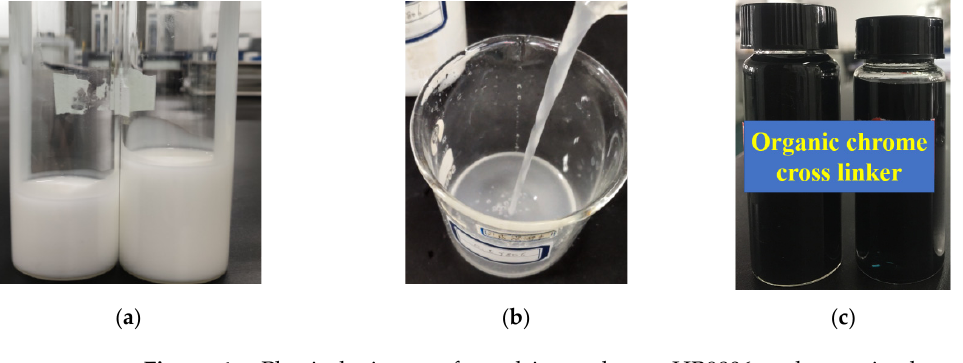
Figure 1. Physical picture of emulsion polymer HR9806 and organic chromium crosslinker. ( a ) Emulsion polymer HR9806; ( b ) 0.5 wt % HR9806 emulsion polymer base liquid; ( c ) organic chrome crosslinker.